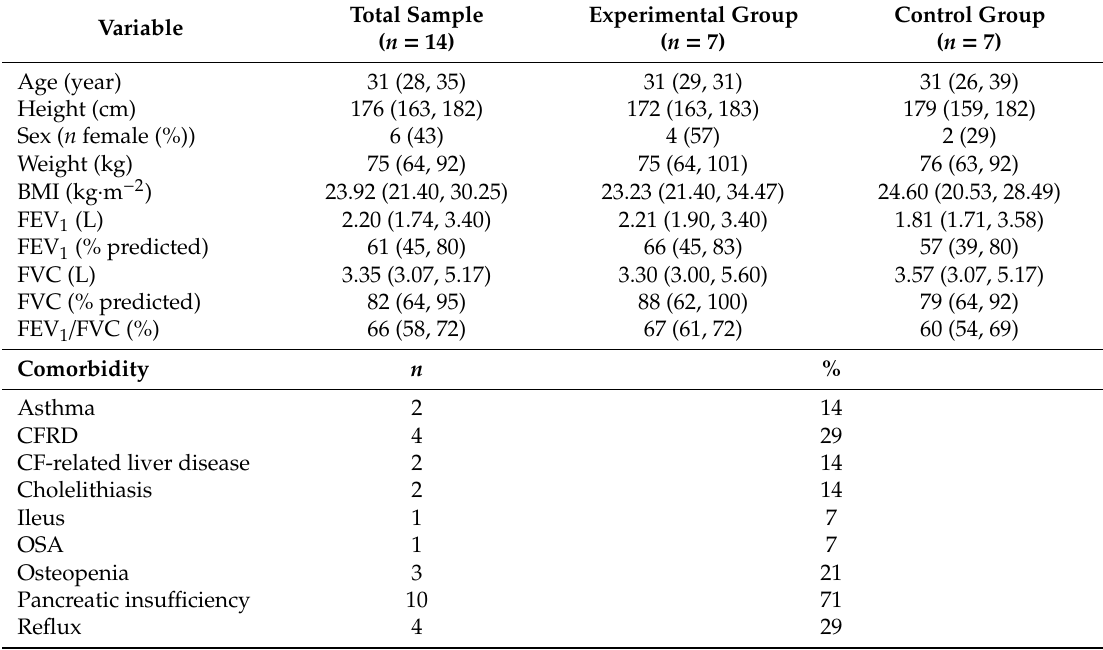
Table 1. Participant